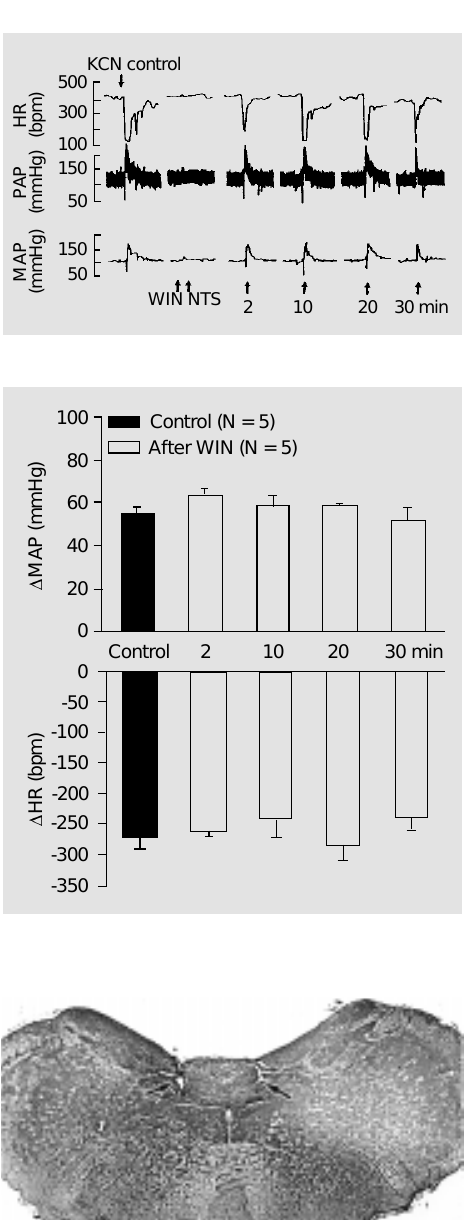
Figure 2 - Typical tracing of a conscious rat representative of the group showing the changes in heart rate (HR), pulsatile arte- rial pressure (PAP) and mean ar- terial pressure (MAP) in re- sponse to chemoreflex activa- tion with potassium cyanide (KCN, 40 µg/rat, iv ) before and 2, 10, 20 and 30 min after bilateral microinjection of WIN (2.5 nmol/ 50 nl) into the commissural NTS.